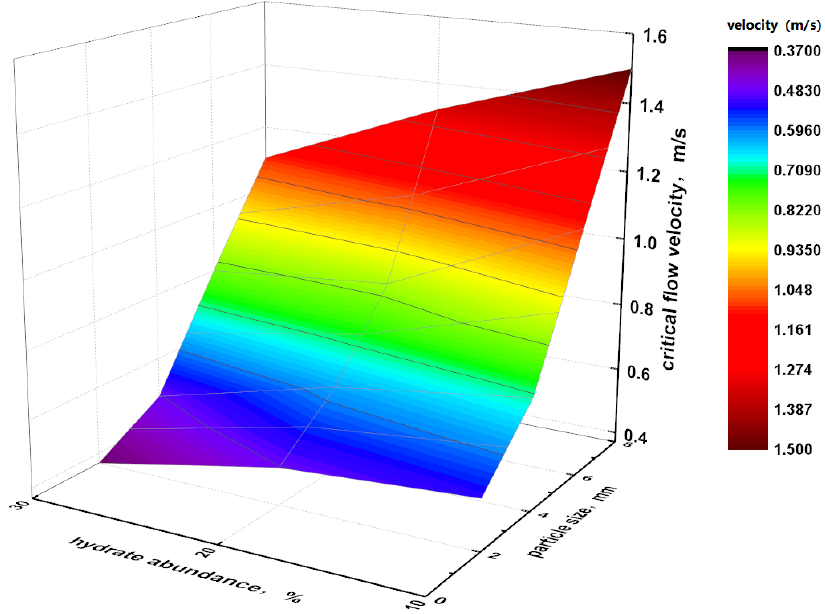
Figure 8. The critical flow velocity plate of different hydrate abundance and particle size under 45-degree angle expansion.